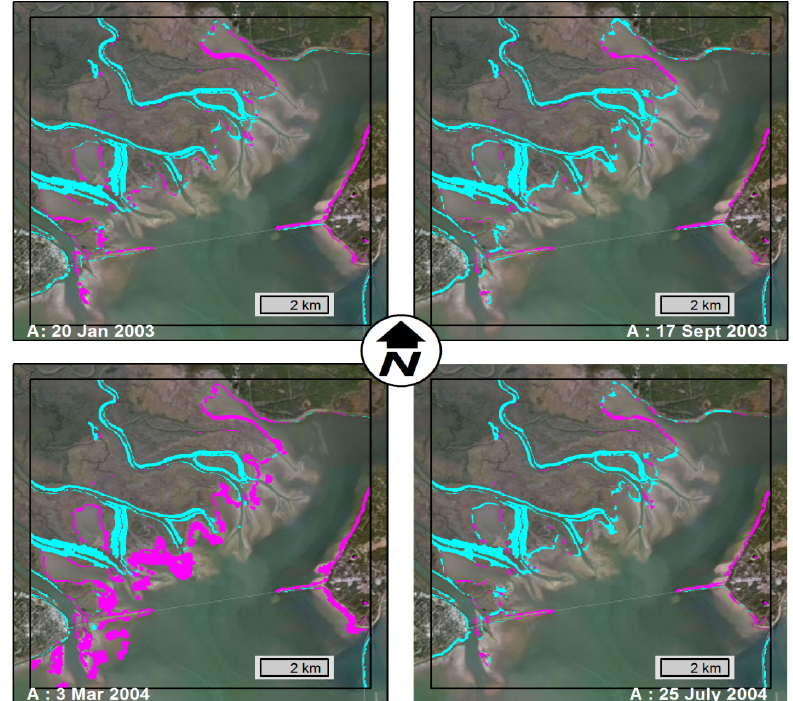
Figure 7. Synoptic inundation results for Assessment Area A (Apalachicola). Pixels incorrectly predicted as DRY are shown in magenta; pixels incorrectly predicted as WET are shown in cyan. Other areas within the square boundary were